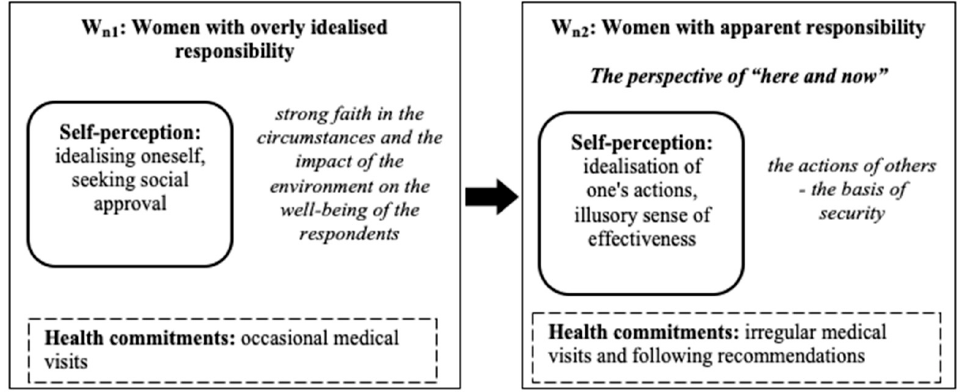
Figure 5. The two sub-models (W n1 , W n2 ) were distinguished which show the transformation of responsibility for one’s own health from excessively idealised responsibility to apparent responsibility.